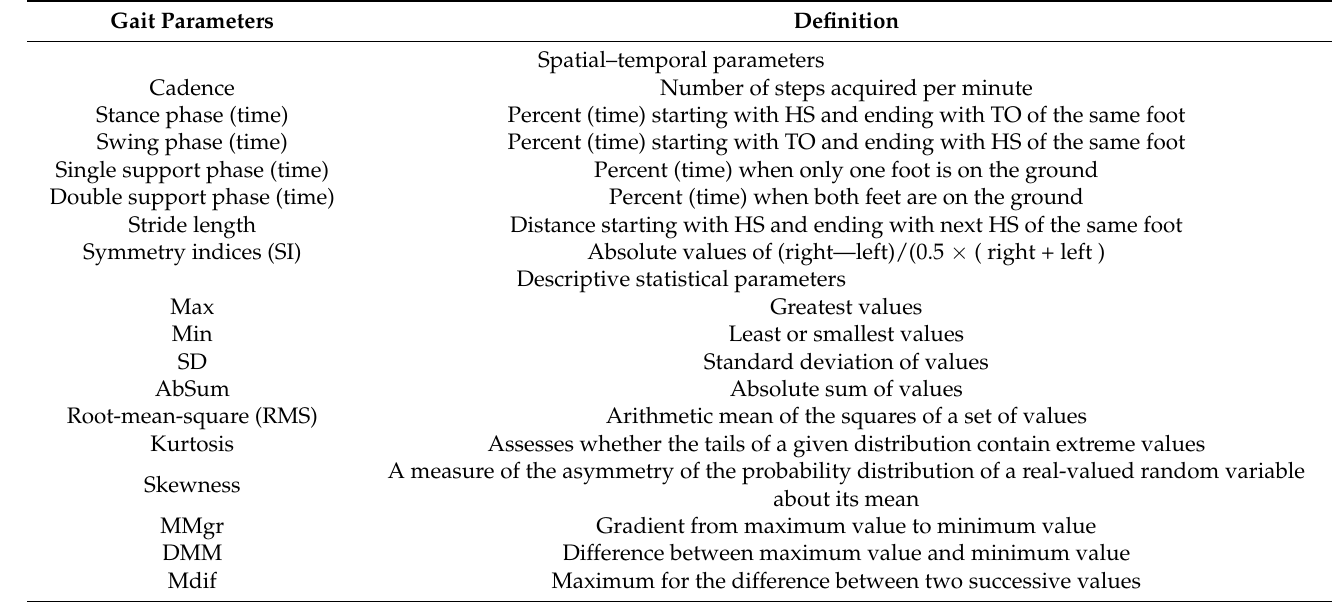
Table 3. Definition of gait